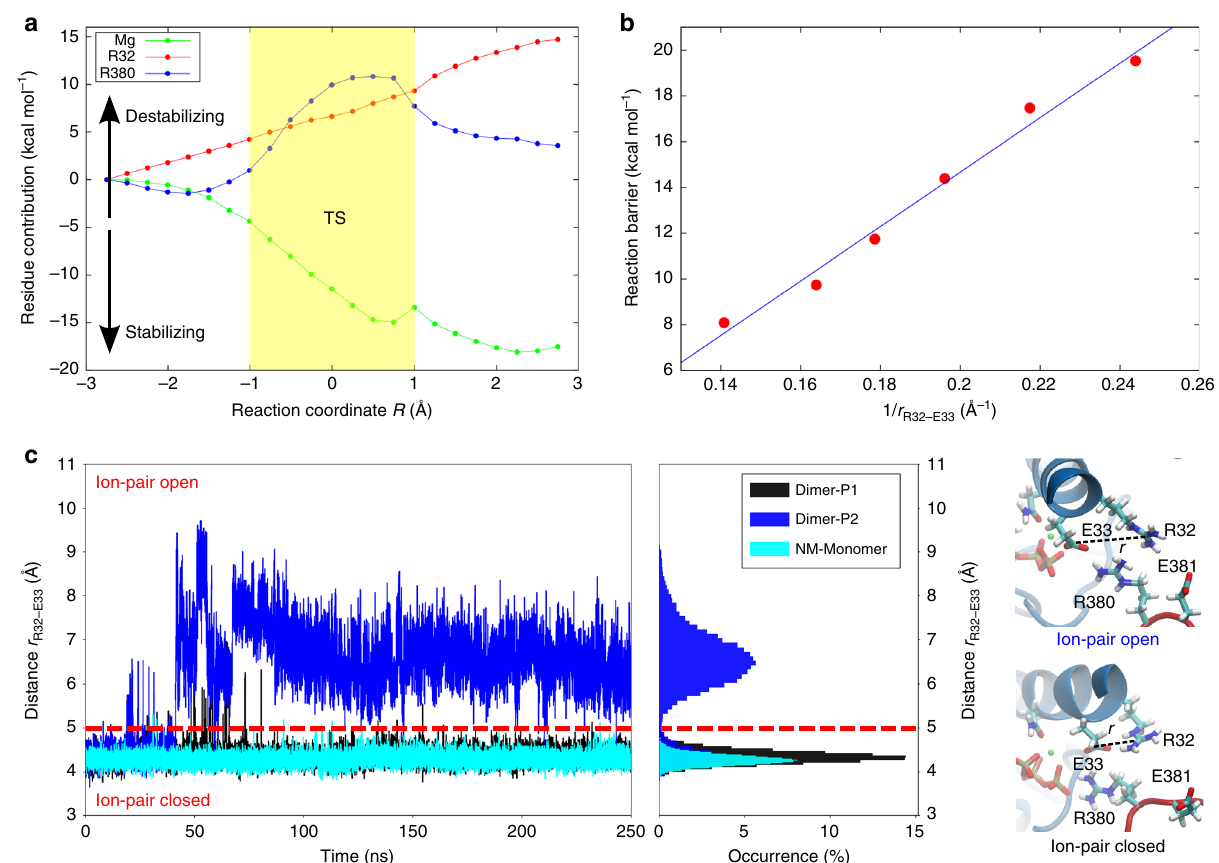
Fig. 3 Analysis of the catalytic effects in Hsp90. a Energy decomposition of the catalytic effects. The fi gure shows the energy difference relative to the wild-type calculation, obtained by switching off individual residue contributions, with the transition state (TS) region marked in yellow (see also Supplementary Fig. 3). b Reaction barrier for ATP hydrolysis at different Arg-32/Glu-33 distances (see also Supplementary Fig. 4). The energy barrier is ca. 20 kcal mol − 1 in the DFT models and thus slightly lower as compared with the QM/MM models with explicit treatment of the protein surroundings. c Arg- 32/Glu-33 distance from MD simulations of the full-length Hsp90 dimer (in blue and black) and for the monomeric NM-domain model of Hsp90 (in cyan). All Arg-32/Glu-33 distances are measured between the C ζ (Arg-32) and C δ